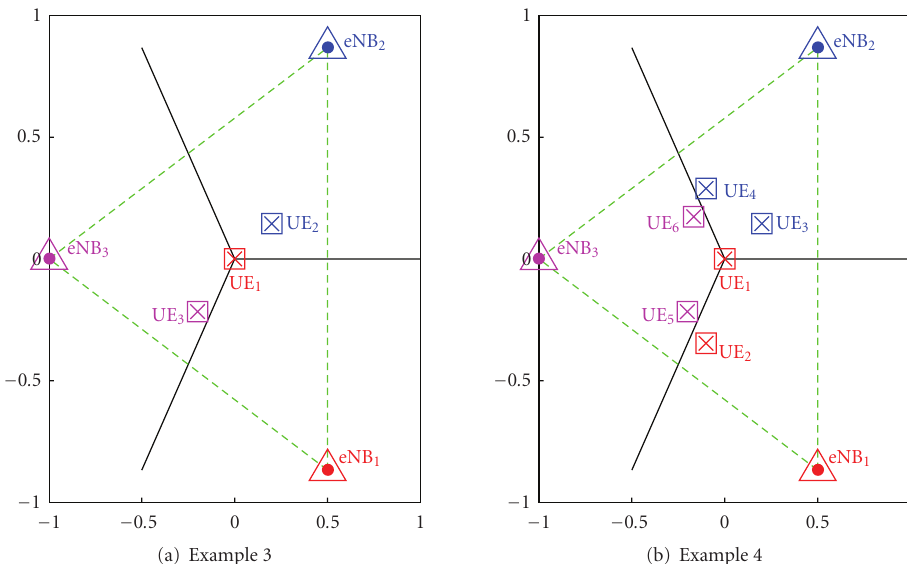
Figure 1: System configurations of two multicell examples: (a) 3 eNBs and 3 UEs. (b) 3 eNBs and 6 UEs. The coordinates of relevant eNBs and UEs shown here are employed for simulations. Note that UE 1 is right on the edge of three cells in both systems. In example 3, UE 3 is near the cell edge between cells 1 and 3. In example 4, UE 2 and UE 2 are near the cell edge between cells 1 and 3, and UE 4 and UE 6 are near the cell edge between cells 2 and 3. (Legends: Each UE is associated with the eNB in the same